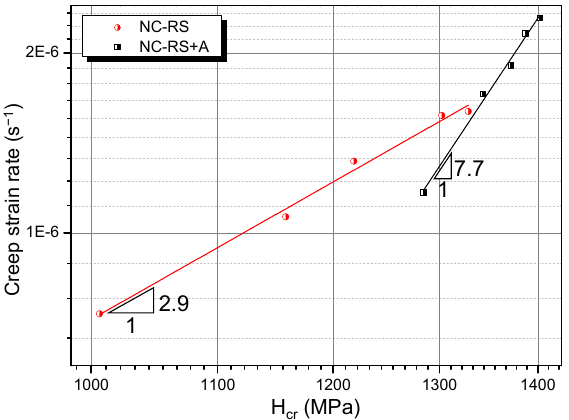
Figure 11. Calculation of the creep stress exponent based on the work-of-indentation theory. Table 2. Comparison between creep stress exponents obtained via conventional and work-of inden- tation.